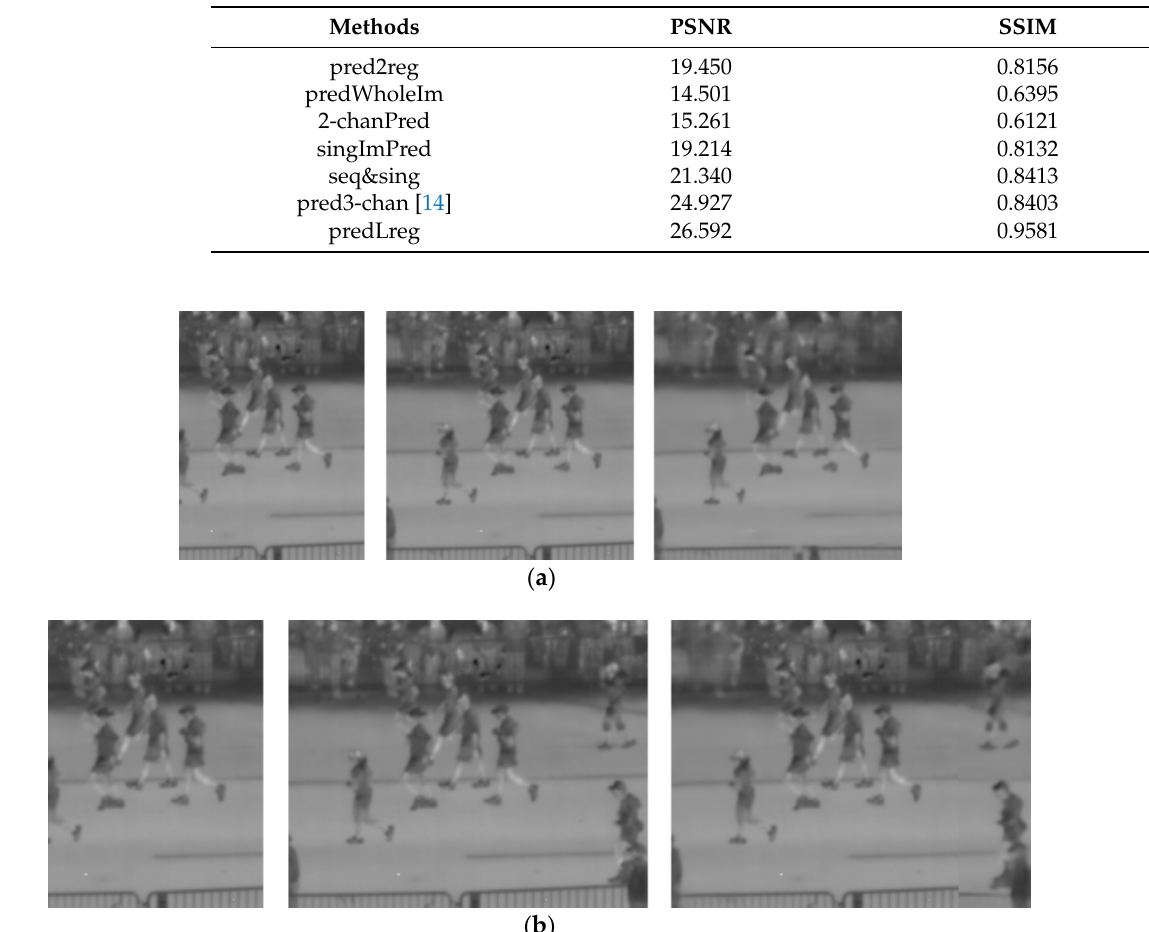
Figure 8. Examples of result images obtained by predLreg and predLRreg (proposed method): from left to right, input, GT , and output images obtained by ( a ) predLreg and ( b ) predLRreg (proposed method).